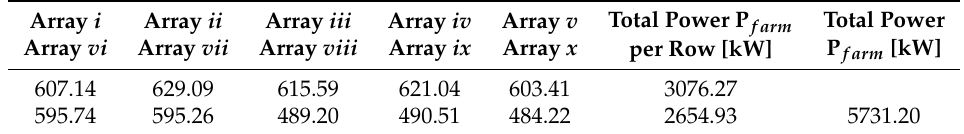
Table 6. Power output in kW for the 50 OSWEC farm for an irregular wave of H m 0 = 1.7 m and